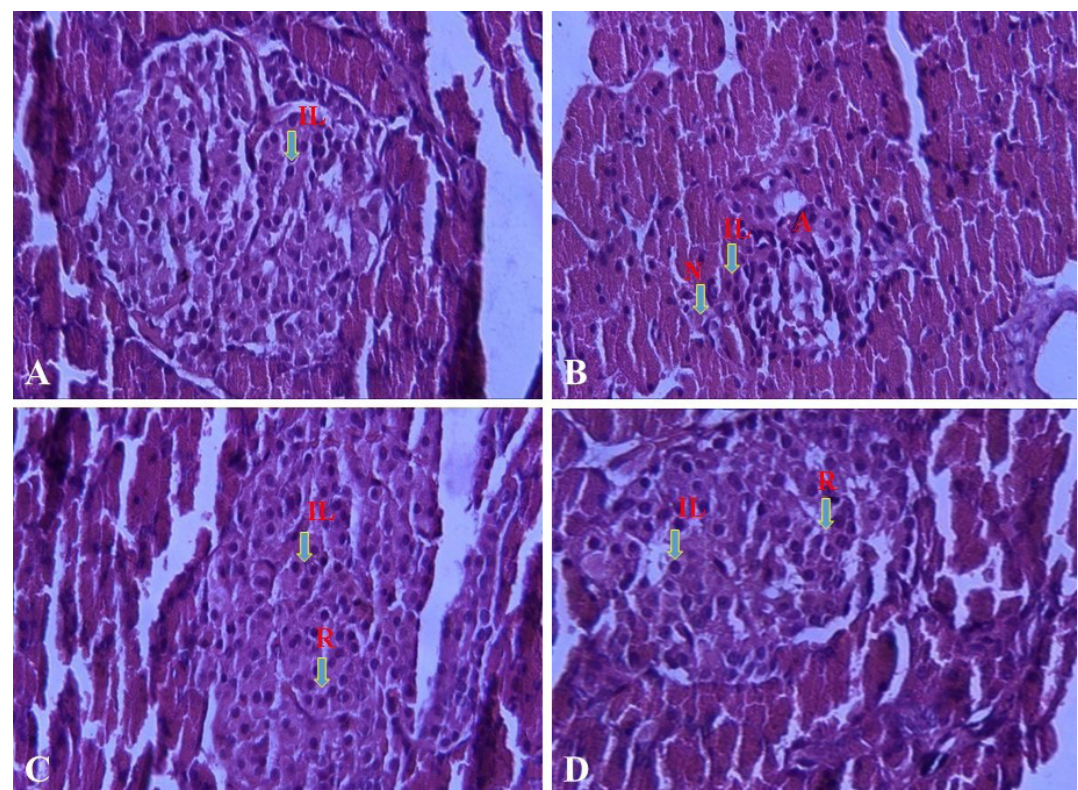
FIGURE 3 – Histopathological study of pancreatic tissues in rats (A) Normal Control pancreas; (B) Diseased pancreas; (C) Glibenclamide treated pancreas; (D) EAE treated pancreas at 200 mg/Kg b.w. (A: Acini; IL: islets of Langerhans; N: necrosis, R: